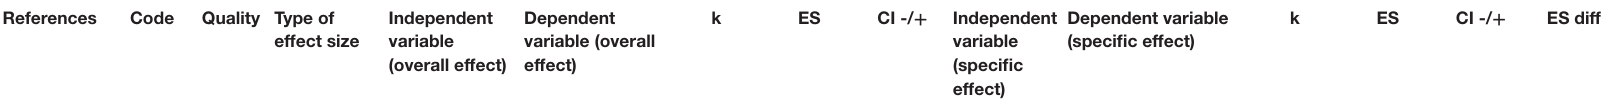
TABLE 2 | Effectiveness